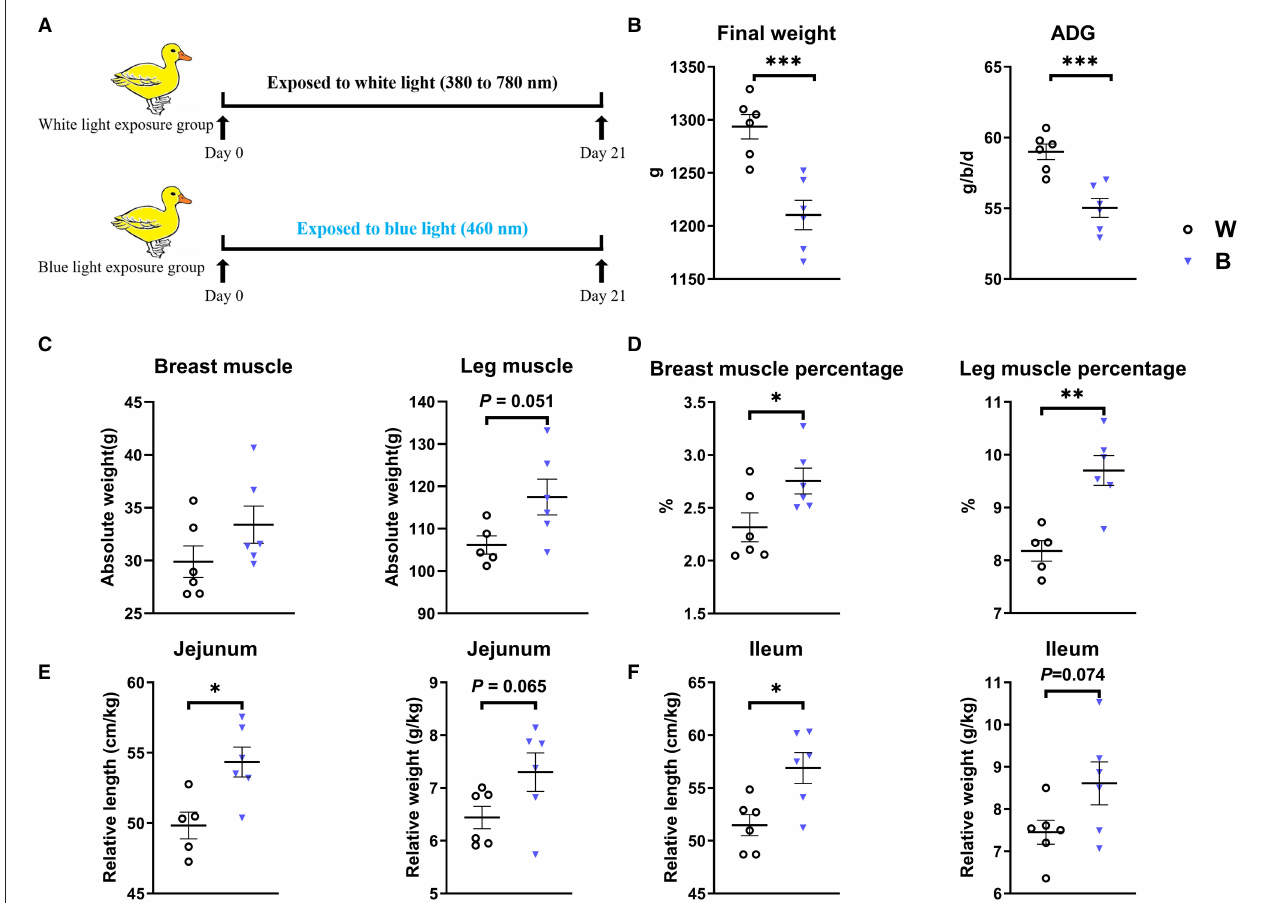
FIGURE 1 | Exposure to blue light reduces body weight but increases the muscle percentage in ducklings. (A) Scheme of the experiments. (B) Effect of exposure to blue light on growth performance of ducks from days 1–21 ( n = 6, mean with SEM). (C) Effect of exposure to blue light on the absolute weight and percentage of breast muscle. (D) Effect of exposure to blue light on the absolute weight and the percentage of leg muscle. (E) The effect of blue light irradiation on the relative length and weight of duck jejunum. (F) The effect of blue light irradiation on the relative length and weight of duck ileum. Data in (B–F) were analyzed using the unpaired t -test, * P < 0.05, ** P < 0.01, *** P <